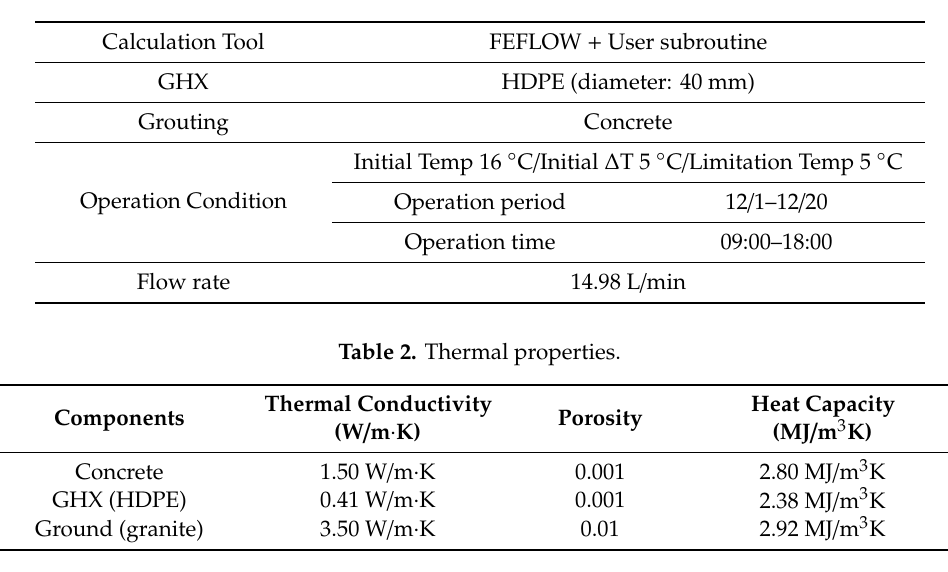
Table 1. Simulation conditions.